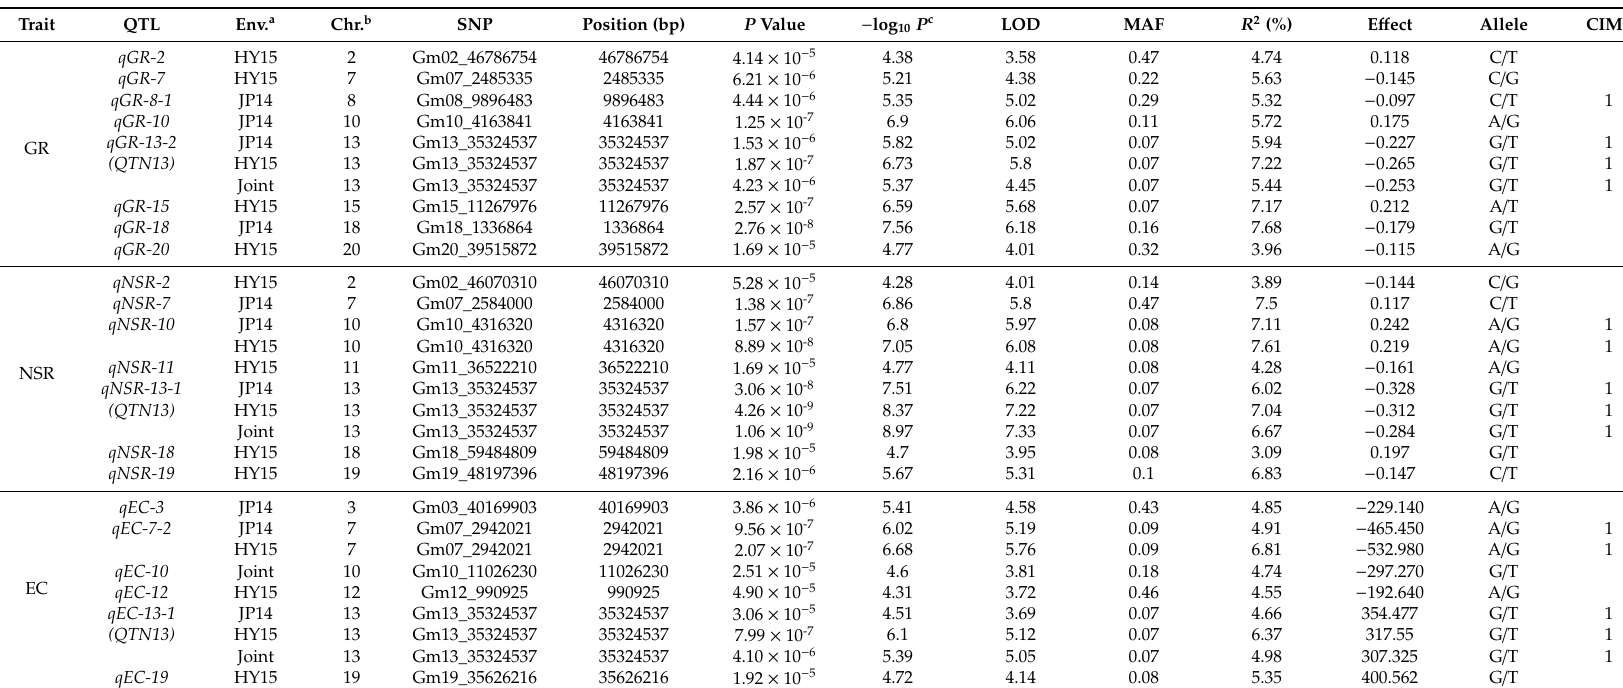
Table 3. Quantitative trait nucleotides (QTNs) associated with germination rate (GR), normal seedling rate (NSR) and electric conductivity (EC) via mrMLM.